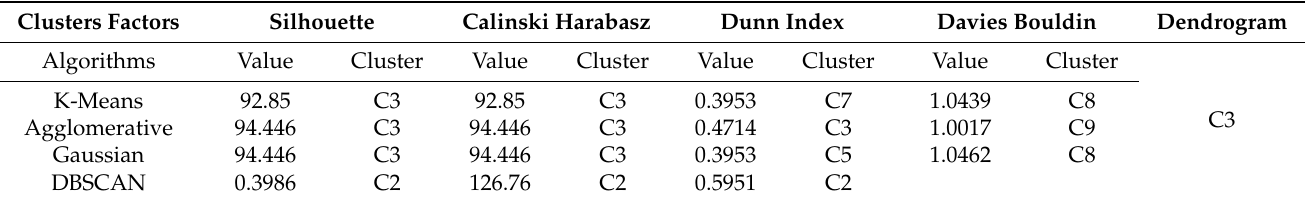
Table 5. Validation metrics of different cluster factors analysis using different algorithms for 10 clusters.